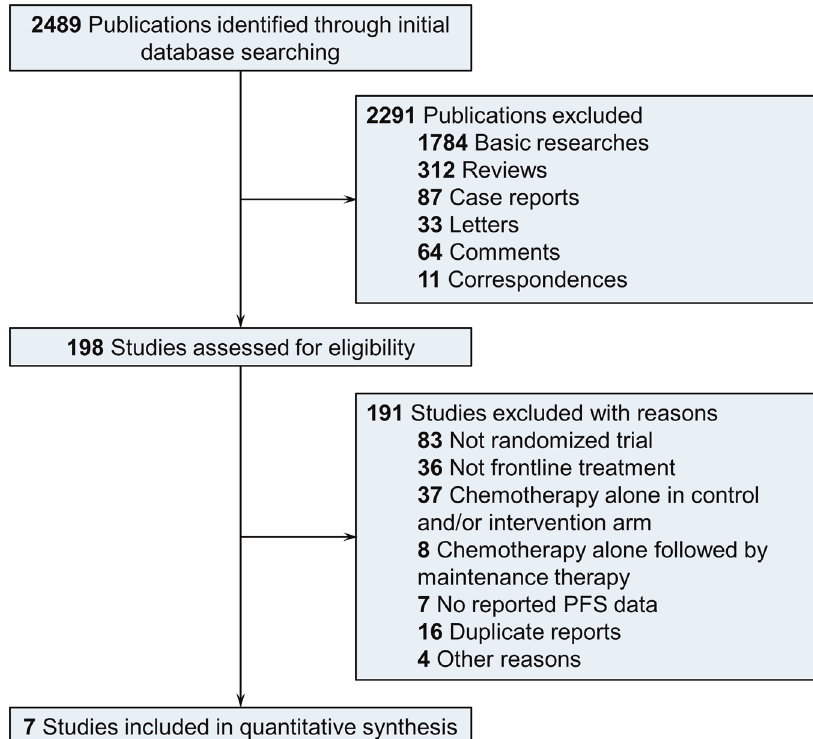
Fig. 1 PRISMA fl owchart of the study selection